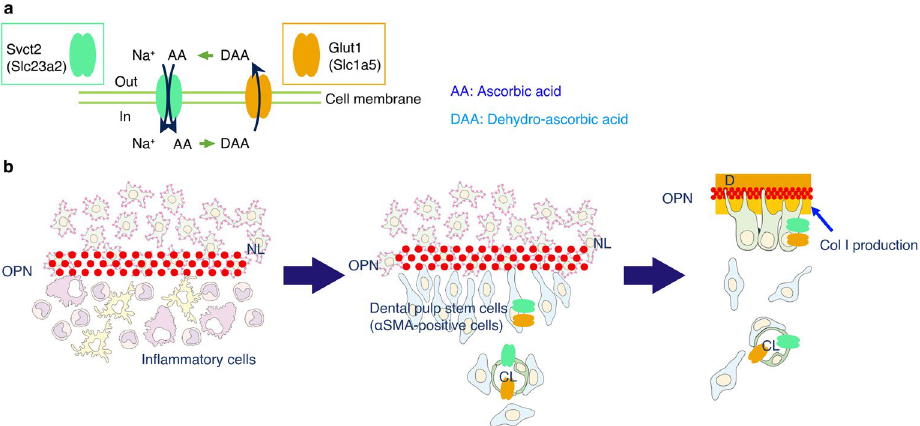
Figure 7. Schematic diagram of the putative relationship in the pulp–dentin border in the wound healing process after pulpotomy followed by MTA capping. AA, ascorbic acid; DAA, dehydro-ascorbic acid; OPN, osteopontin; NL, necrotic layer; OB, osteoblast; CL, capillary lumen; D, dentin ( a ). The pathway of the AA, ( b ) the role of the transporter of AA during wound healing. Immediately after pulp capping, OPN is deposited at the NL—inflammatory cell layer interface. Then, α-SMA-positive stem cells are recruited along the OPN layer. Finally, dental pulp stem cells differentiated the odontoblast-like cells, and subsequently, the odontoblast-like cells produced Col I to generate the reparative dentin. During the wound healing process in the dental pulp tissue, SVCT2 and GLUT1 might be involved in the differentiation of odontoblasts or wound healing in pulp tissue due to the supply of the AA. This figure was drawn by Naoto Ohkura using Illustrator 2022 (Adobe, San Diego, CA,